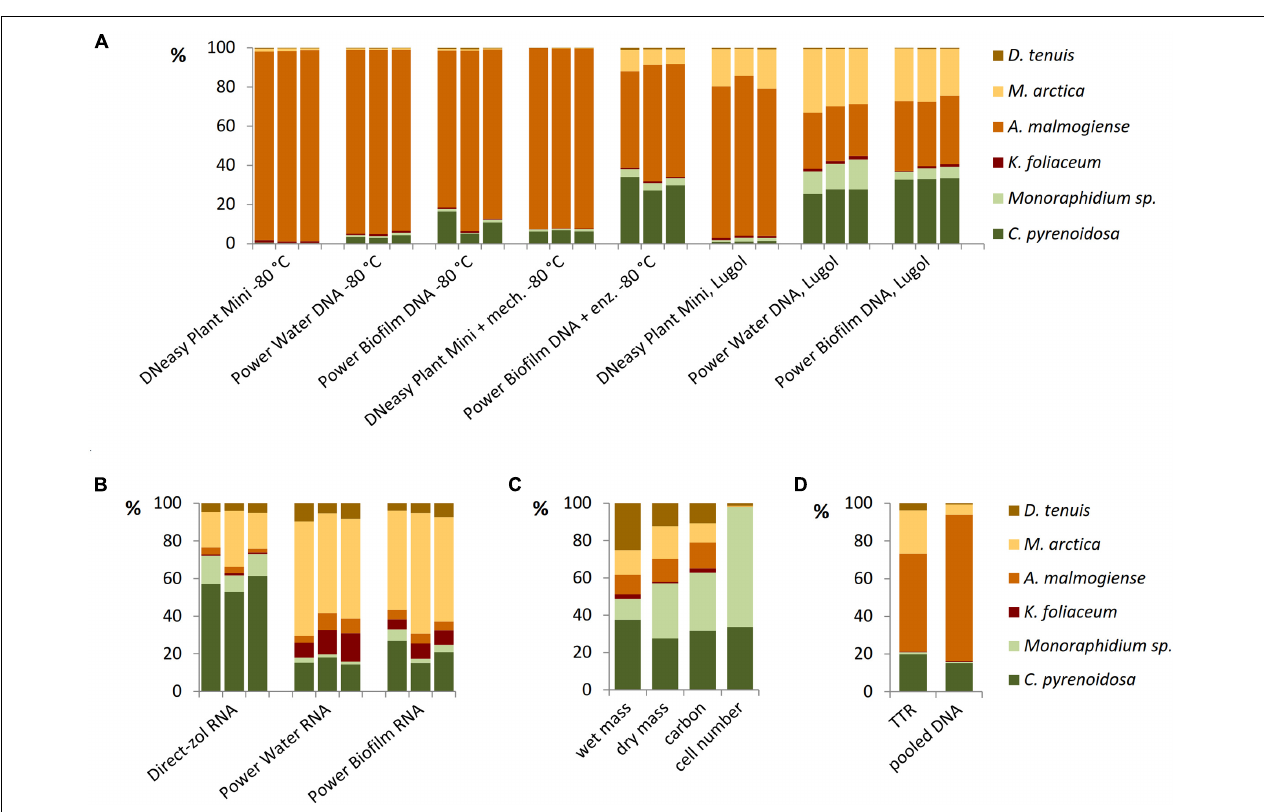
FIGURE 6 | Relationships of mock community strains based on (A) 18S rRNA gene analyses of DNA extractions and (B) 18S rRNA analyses of RNA extractions, (C) microscopically determined wet biomasses and cell numbers and dry mass and carbon content determinations, and (D) theoretical results based on separately extracted DNA’s of mock strains using Power Biofilm kit. TTR refers to theoretical template relationship, when DNA extracts of strains were isolated and amplified separately counting the results based on individual 18S qPCR results, and pooled DNA refers to a sample containing equal amounts (weight) of DNA of mock strains.